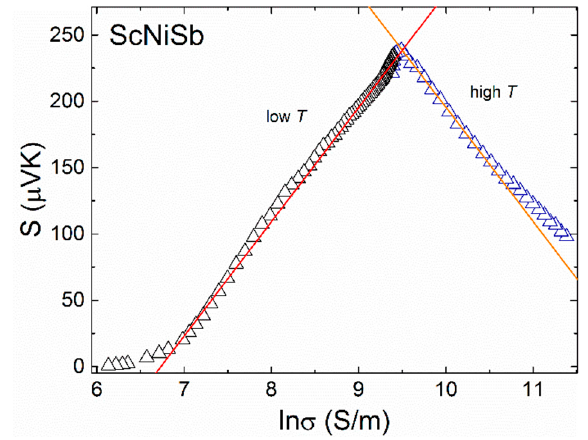
Figure 4. Jonker plot of the electrical conductivity and the Seebeck coe ffi cient data of ScNiSb.